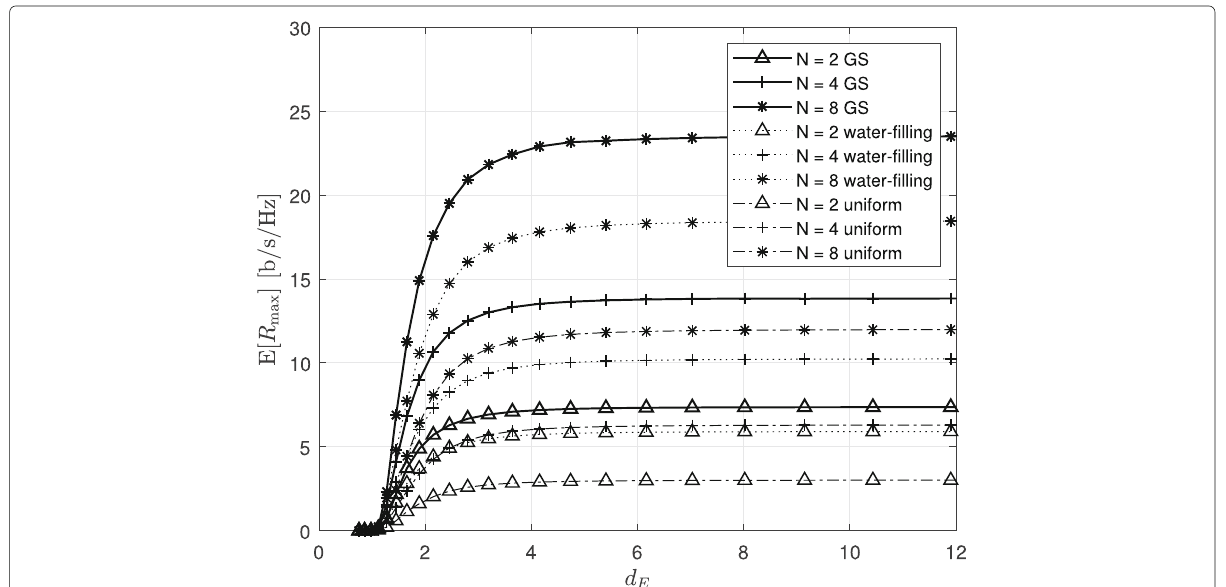
Fig. 13 Average maximum outage secrecy rate as a function of d E , with finite-length coding ( m = 4096) and discrete (16-QAM) constellations, obtained using optimal power allocation, water-filling, and uniform power